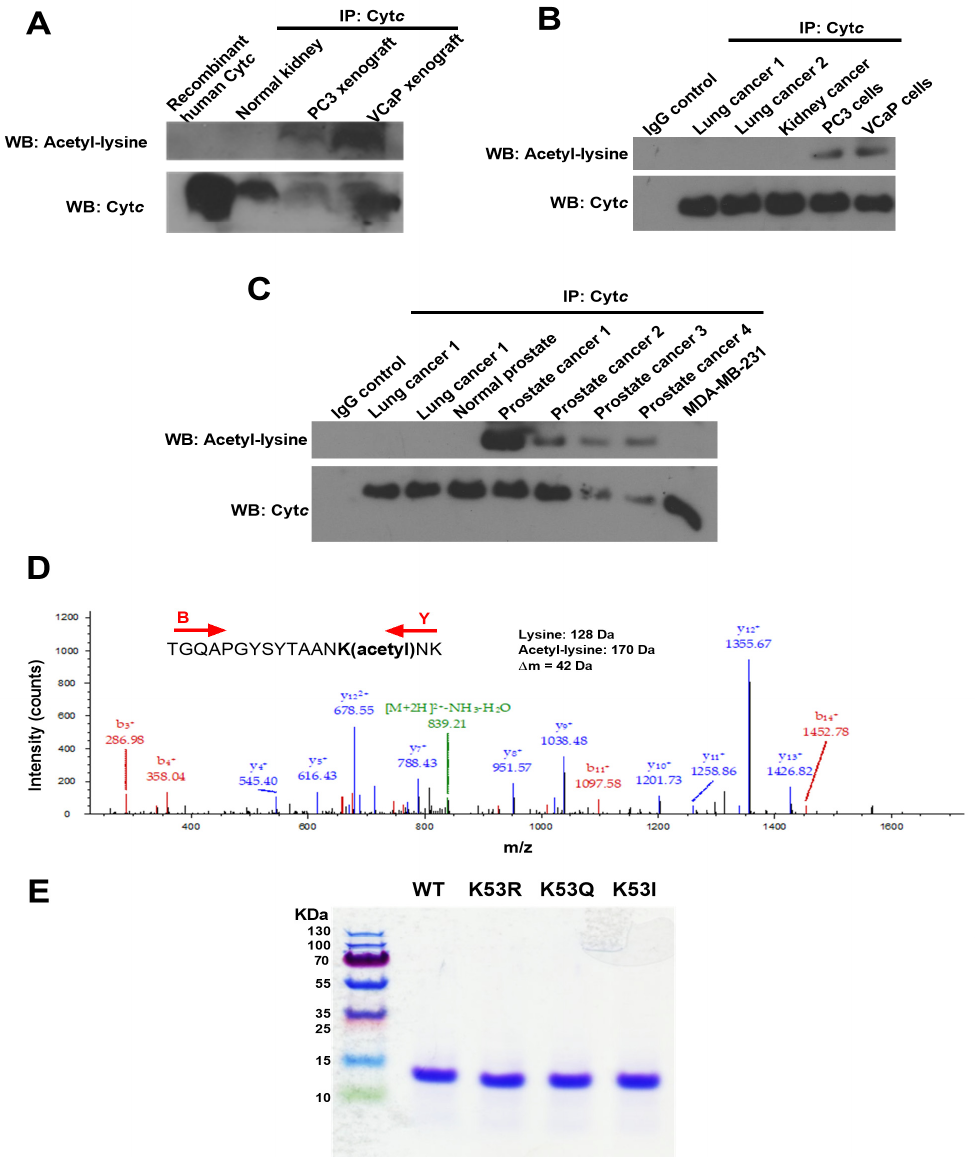
Figure 1. ( A ) Cyt c is acetylated in castrate-resistant (PC3) and castrate-sensitive (VCaP) prostate cancer xenograft tissues compared to normal human kidney tissue and recombinant human Cyt c . ( B ) Cyt c is acetylated in cultured PC3 and VCaP cells, but not acetylated in lung and kidney cancer tissues. ( C ) Cyt c is acetylated in human prostate cancer tissues, but not acetylated in normal prostate tissue, lung cancer tissue, and MDA-MB-231 cells. ( D ) Mass spectrum of Cyt c peptide TGQAPGYSYTAANK(acetyl)NK identifying Cyt c K53 acetylation (underlined). This spectrum represents one immunoprecipitated castrate-sensitive tumor xenograft. The acetyl moiety was unambiguously assigned to this lysine via fragment ions y4+, y5+, etc., and b14+ containing 42 extra mass units for the acetyl group. The peptide sequence was unambiguously revealed by fragment ions b3+, b4+, b11+, b14+, y4+, y5+, y7+, y8+, y9+, y10+, y11+, y12+, and y13+. ( E ) Coomassie blue-stained gel showing the purity of recombinant Cyt c overexpressed and purified from bacteria. All 4 Cyt c variants displayed a single band on a 10% tris-tricine SDS-polyacrylamide gel at around 12 kDa.